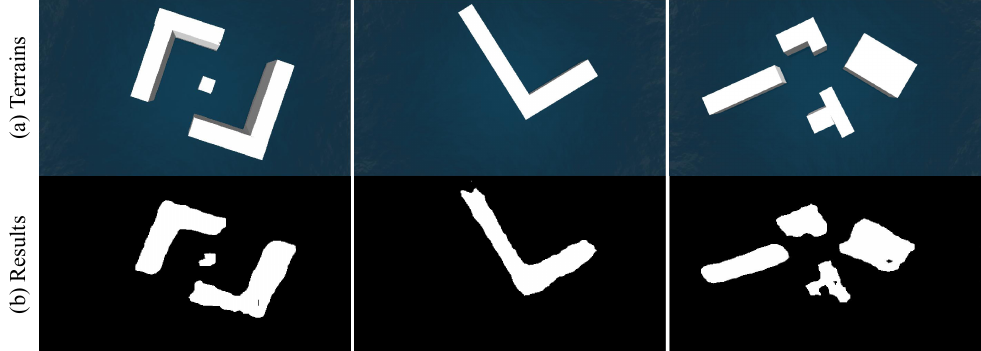
Figure 4. Obstacle recognition results of different terrains.